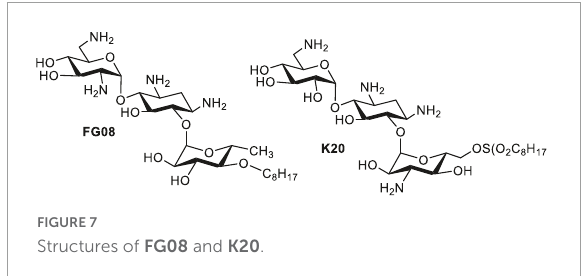
a ATCC12228. b Vancomycinresistantenterococcus. c ATCC29212. d Tobramycinresistant(AAC(6 (cid:48) )/APH(2 (cid:48)(cid:48) )).